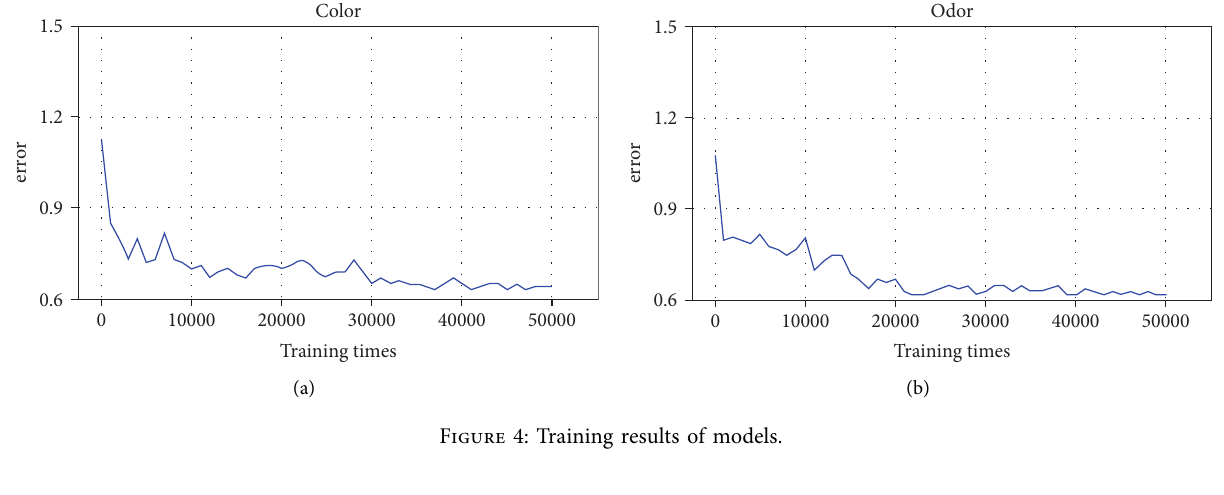
Figure 4: Training results of